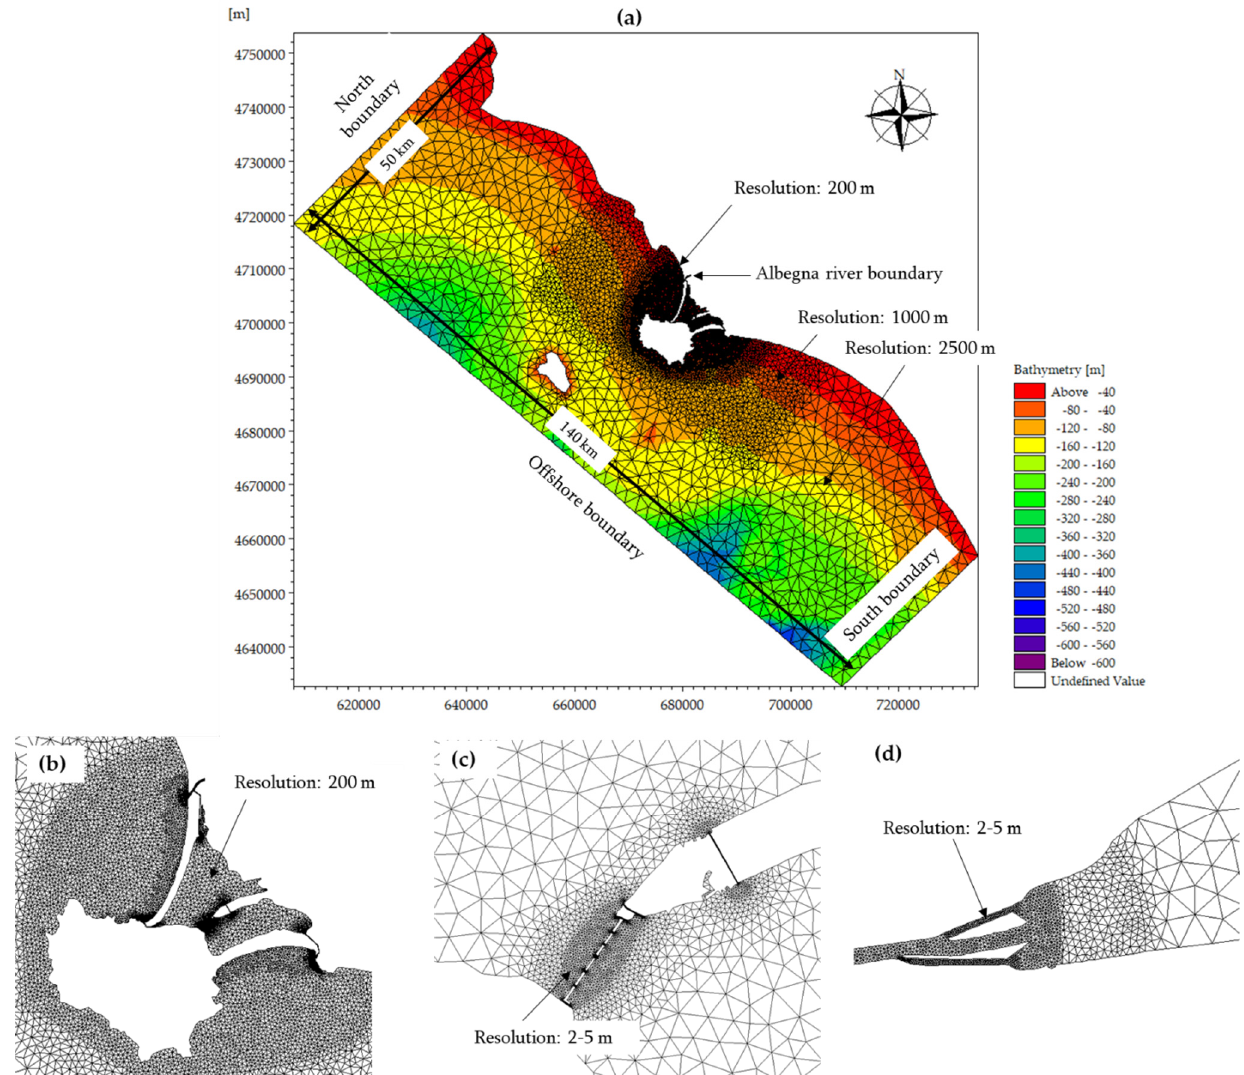
Figure 3. Digitalization of the bathymetry of the numerical domain in the present scenario, with naming convention for boundaries and mesh resolution in the different zones ( a ): close-up views of the mesh around the Orbetello Lagoon ( b ), Ponte Diga zone ( c ), and Nassa inlet ( d ). Time series of hourly water levels, temperature, and salinity, varying in space and time along each boundary, were used as offshore, north, and south boundary conditions (the naming convention for boundaries is reported in Figure 3a). Such data were extracted